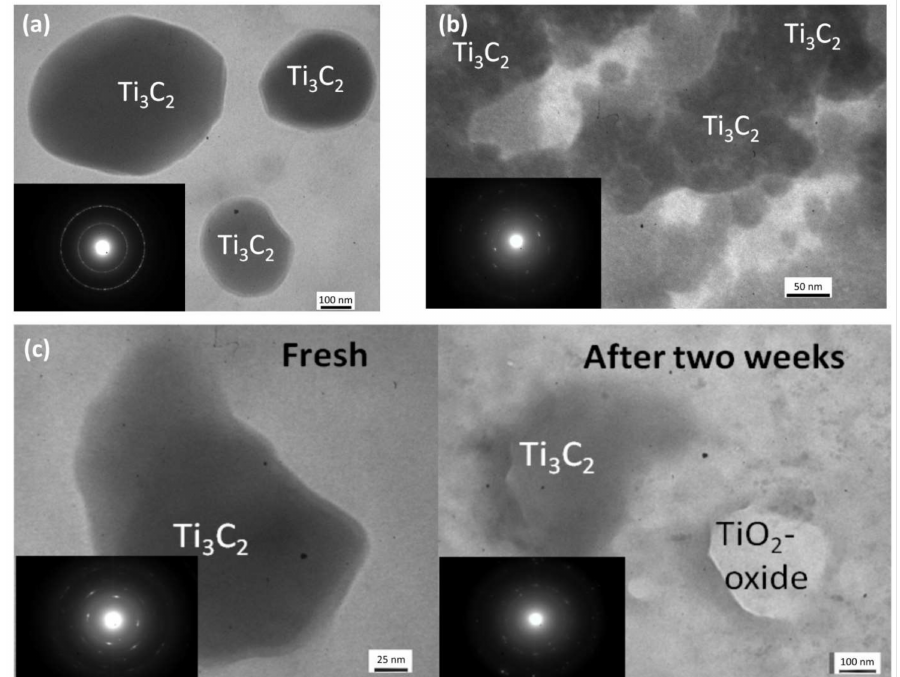
Figure 5. TEM images of the structure of Ti 3 C 2 MXenes obtained by the method of dripping onto a substrate and their electron diffraction patterns: high-concentration drips ( a ), low concentration flakes ( b ), oxidation test ( c